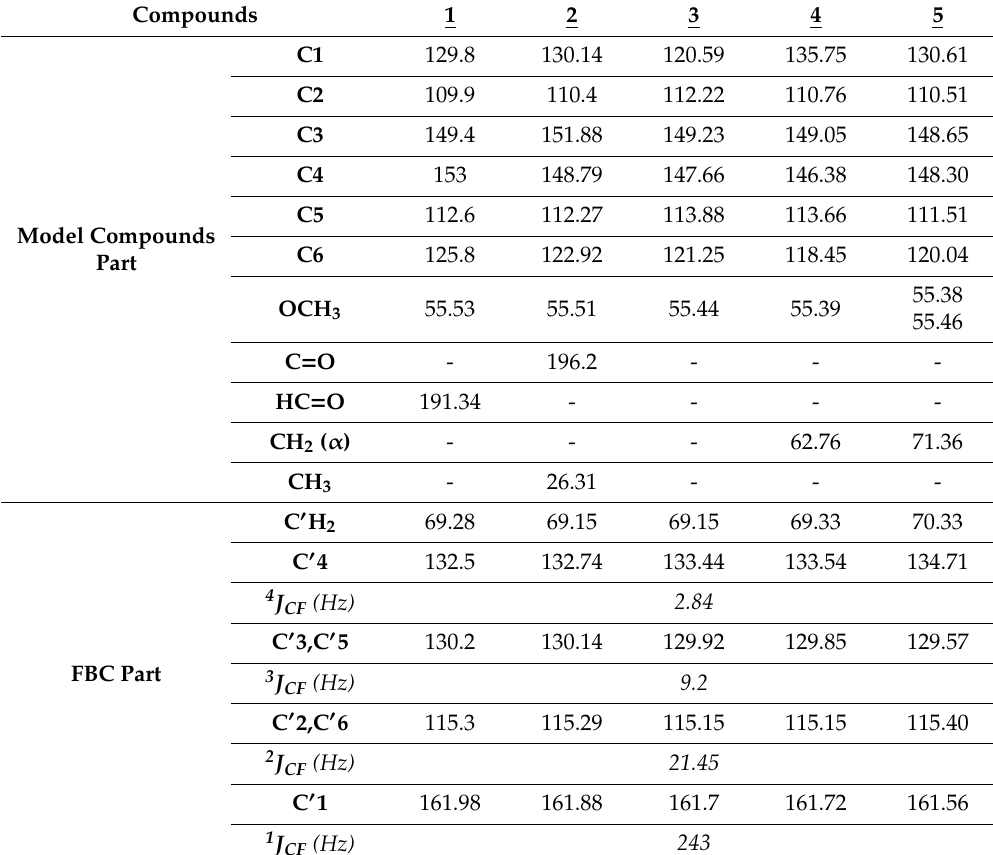
Table 3. 13 C-NMR Chemical shifts (in ppm) of fluorobenzylated model compounds.